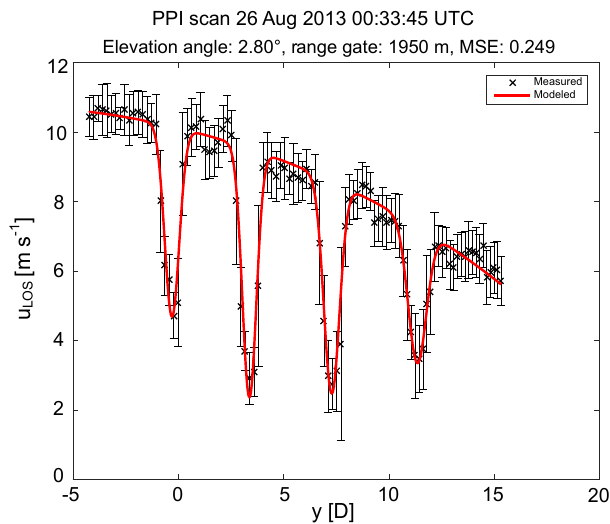
Figure 5. Example of line-of-sight velocity data measured by the scanning lidar at a specific range gate during a PPI scan. Error bars are the dispersion of line-of-sight velocity measurements. The red line represents the fit performed by the wake characterization algo-